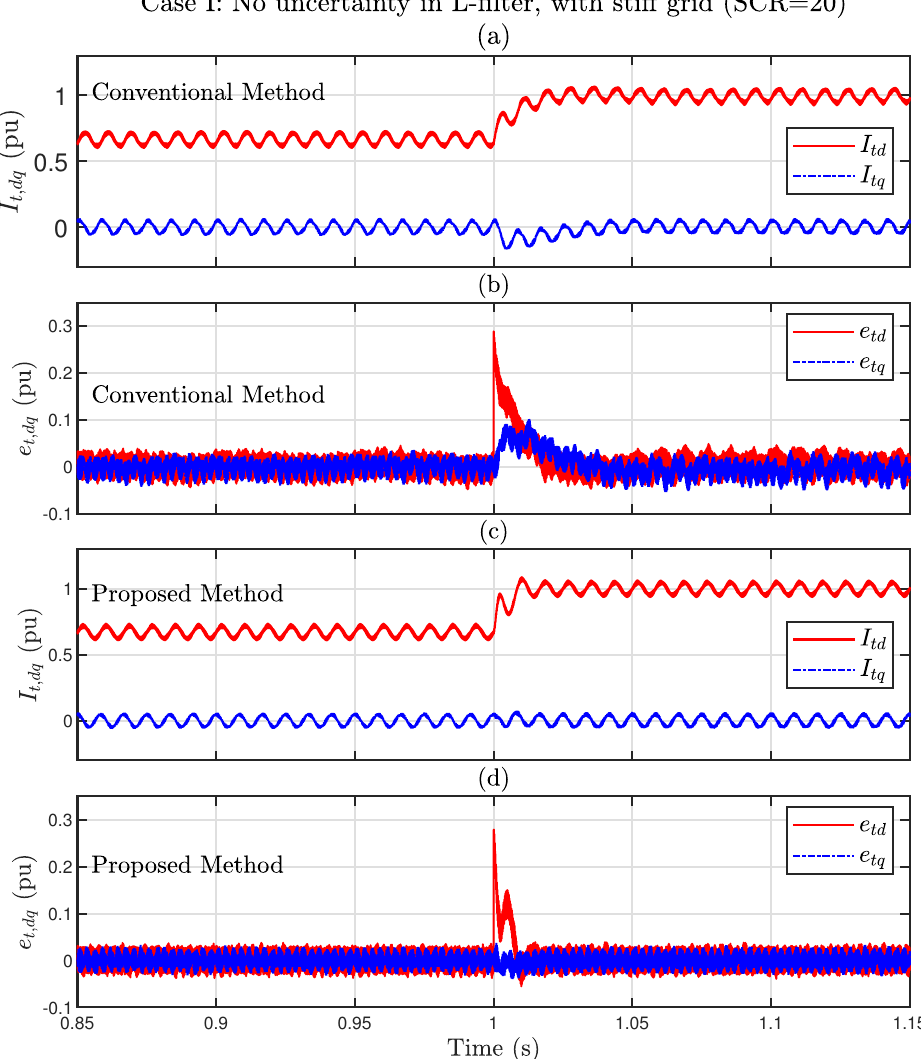
Figure 16. Comparison of the results for Case I: dq components of the inverter currents ( I t , dq ) and error signals ( e t , dq ): ( a , b ) conventional method, and ( c , d ) proposed